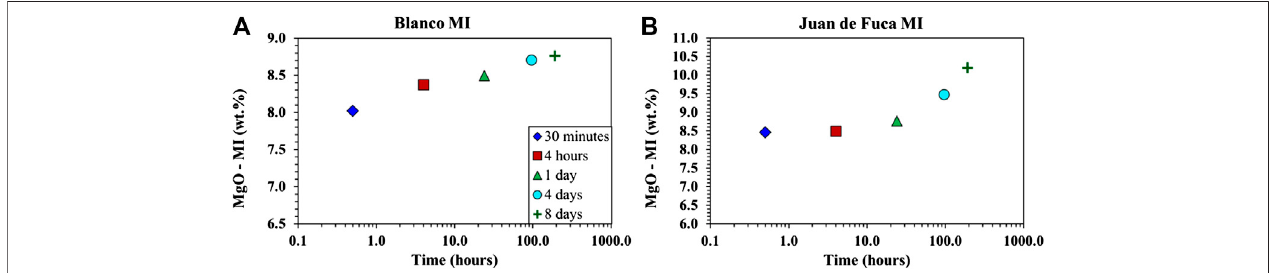
FIGURE3| Majorelementpro fi lesbetweenthehostplagioclaseandtheMIsforlowpressureexperiments.1)Thepro fi lefromtheplagioclasehost(right)intotheMI (left) marked by an increase in MgO. Error bars are located in the upper right corner. 2) BSE images showing the direction and location of traverses. 3) Pro fi le within the plagioclasehostasitapproachestheboundaryoftheMI(markedby0distancefromMI). (A) Pro fi lesandBSEona30minute-lowpressureJuandeFucasample-D23-2. Results show no change in MgO as the traverse approaches the MI boundary. (B) Pro fi les and BSE on 4 days Juan de Fuca-D23-2 low pressure sample. Results show a decrease in MgO as the traverse approaches the MI boundary. (C) Pro fi les and BSE on 8 days-low pressure Juan de Fuca-D23-2 sample. Results show a decrease in MgO as the traverse approaches the MI boundary. Error (1 σ ) in MgO is smaller than the symbols and was determined on the basis of counting statistics.